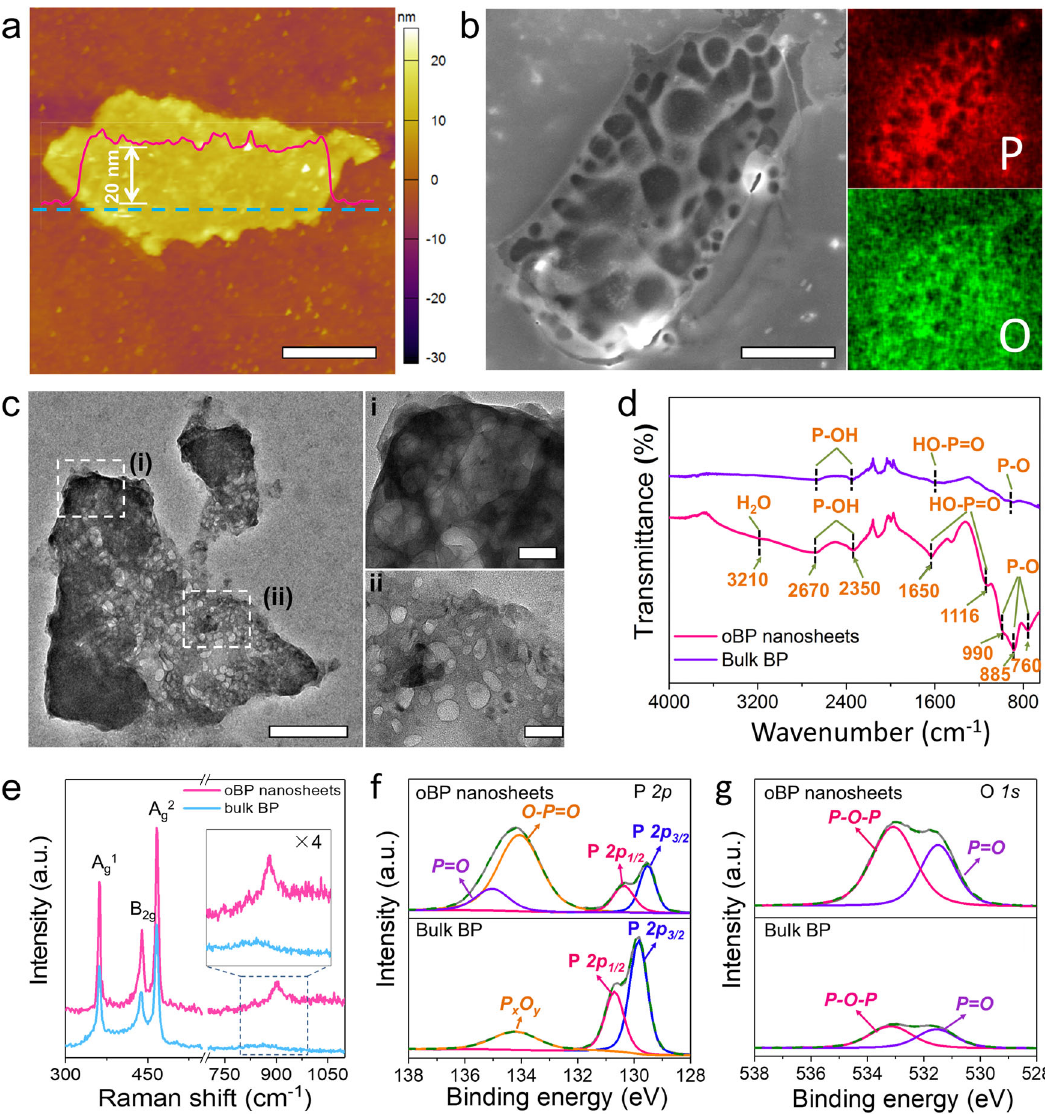
Fig. 2 Structural characterizations of the oBP nanosheets oxidized by dilute HP. a AFM image and the height pro fi le of the oBP nanosheet. Scale bar: 5 μ m. b SEM image of the oBP nanosheet and the corresponding EDS mapping spectra. Scale bar: 5 μ m. c TEM image of the oBP nanosheet. Scale bar: 200 nm. (i and ii) The ampli fi cation images of the corresponding parts in c . Scale bar: 50 nm. d FTIR spectra of the oBP nanosheets and the bulk BP powder (600 – 4000 cm − 1 ). e Raman spectra of the oBP nanosheets and the bulk BP powder (300 – 1100 cm − 1 ). f XPS spectra of P 2p and ( g ) O 1s of the oBP nanosheets and the bulk BP